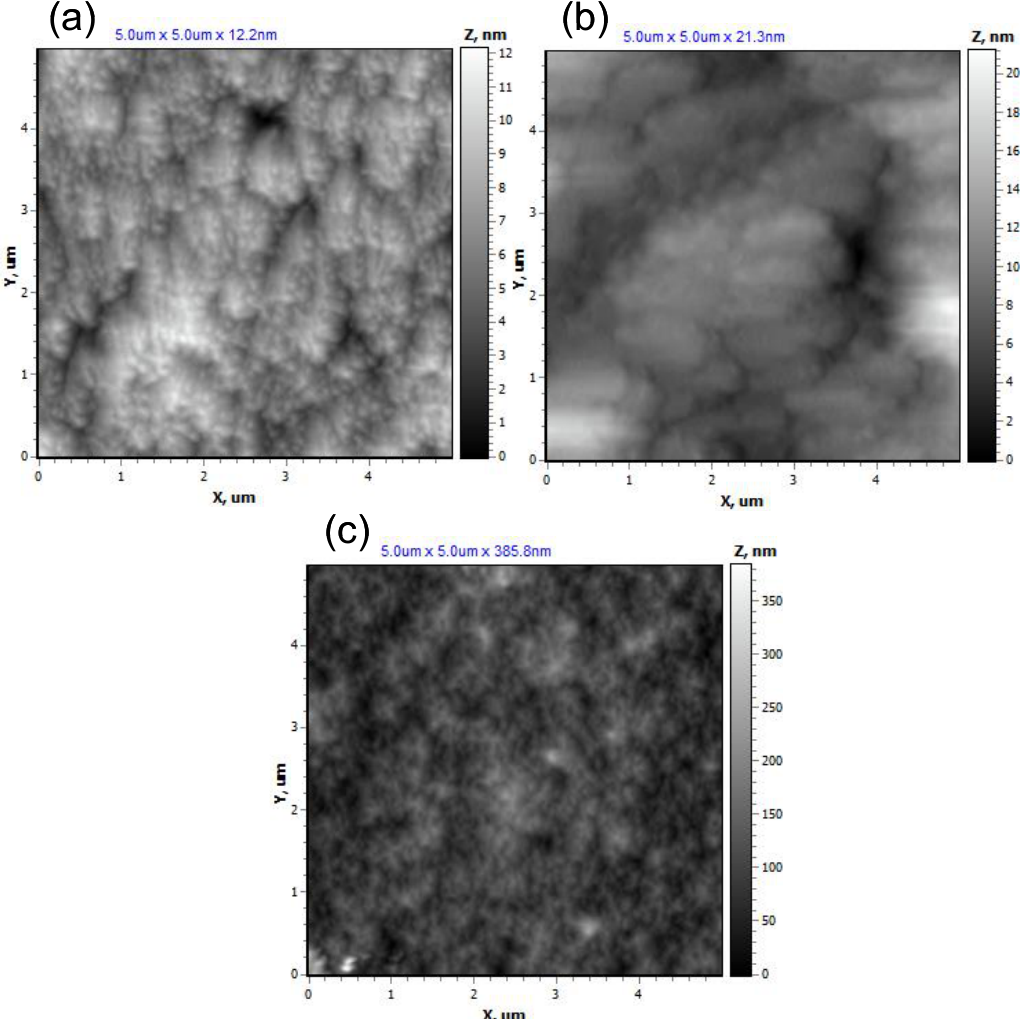
Figure 2. AFM surface topography of ( a ) PETMP-TTT, ( b ) PEDOT:PSS, and ( c ) SiO 2 functional layers. The optical stability of the fabricated SiO 2 /PETMP-TTT/PEDOT:PSS trilayer compo- site was tested employing thermal and solar irradiance treatment. Figure 3a,b show UV-visible transmittance spectra of the trilayer composite before and after thermal (120 °C) and irradiance treatment for different time intervals, respectively. Only a slight de- crease in the transmittance of wavelengths in the range of 350–600 nm was observed after thermal and irradiance treatment of SiO 2 /PETMP-TTT/PEDOT:PSS for 25 h, thus the re- sultant trilayer composite can be considered optically stable and highly transparent for visible light.